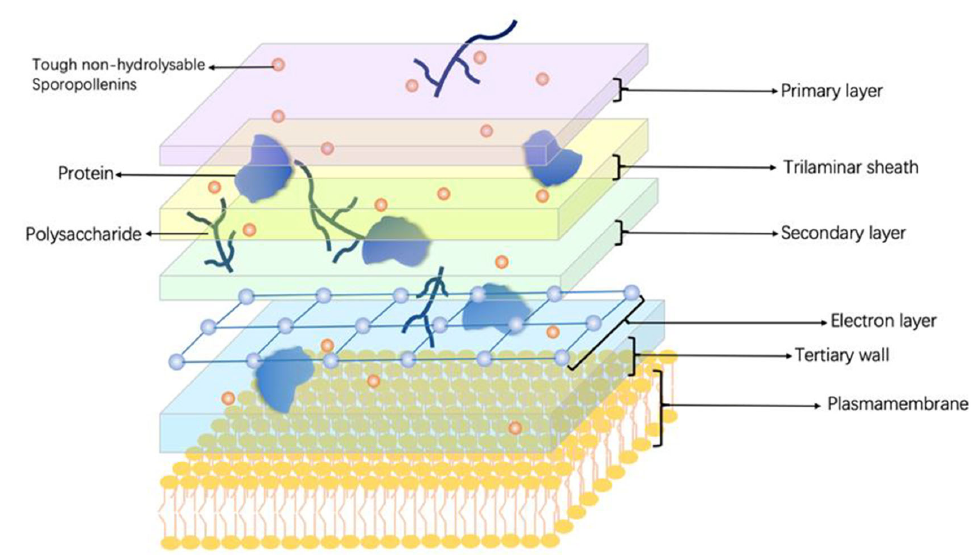
Figure 2. Cell wall structure and chemical compositions of Haematococcus pluvialis . H. pluvialis cells are morphologically classified into four types: flagellated cells, palmelloid cells, intermediate cells, and cysts. During the cyst period, H. pluvialis’s cell wall has a multilayer structure, including a primary layer on the outside, followed by a trilaminar sheath, a secondary layer, a tertiary wall, and an electron later located between the secondary and tertiary wall. Polysaccharides, proteins, and tough non ‐ hydrolysable sporopollenins are the main constituents of the cell wall.